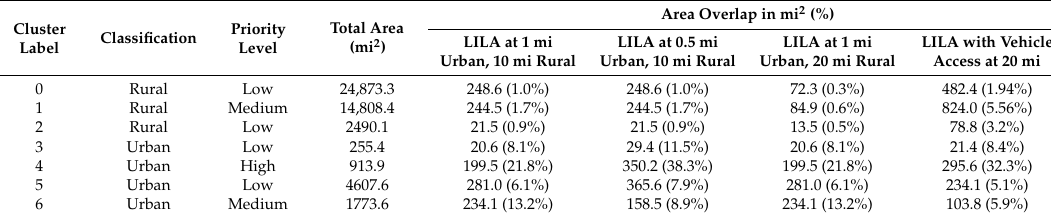
Table 4. Percentage overlap between four USDA food desert definitions and the seven clusters identified in this